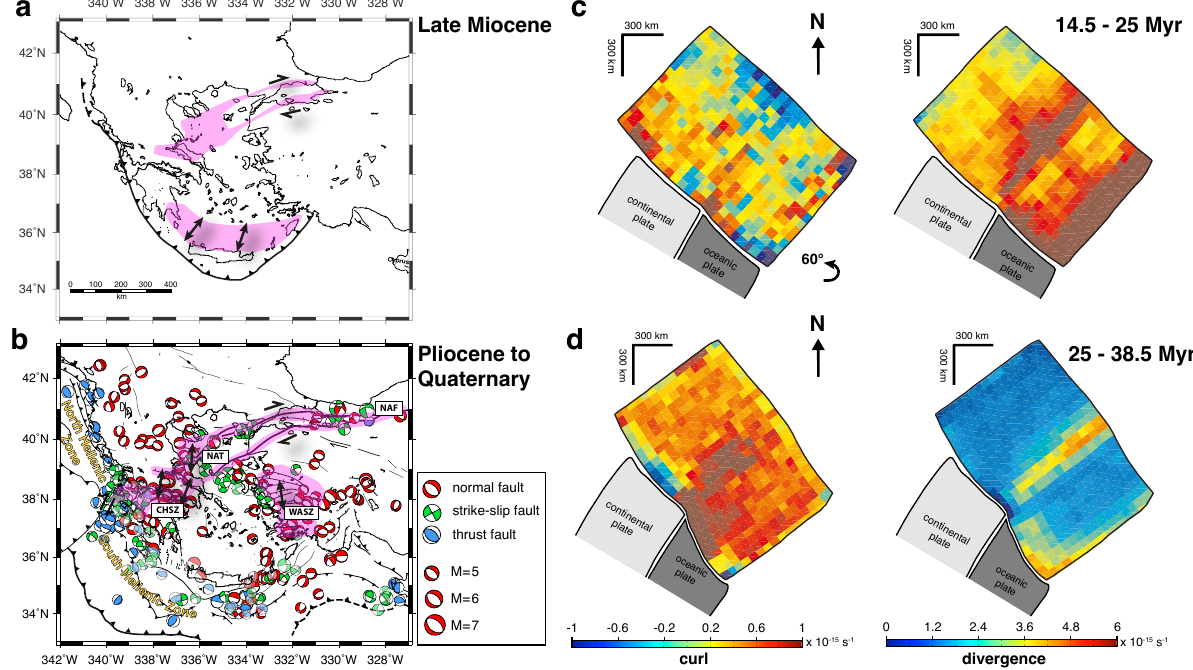
Fig. 9. Upper plate deformation within the Aegean region for (a) the Late Miocene and (b) Pliocene to Quaternary periods (after Royden and Papanikolaou, 2011; Jolivet et al., 2013). The approximate areas affected by extension and/or strike-slip activity for the considered time period are indicated in pink (deformation is not palinspastically restored) and the main active structures and focal mechanisms of earthquakes at depths lower than 50km (source: CMT, 2011) are shown in (b) . Earthquakes with depths between 30 and 50km are indicated with transparent beachballs. (c) Curl (left panel) and divergence (right panel) computed from the overriding plate horizontal displacement field for the 14.5–25Myr time period of model 1. (d) Same as (c) for the 25–38.5Myr time period. A 60 ◦ counterclockwise rotation has been applied to panels (c) and (d) to make the trench orientation fit the orientation of the Hellenic